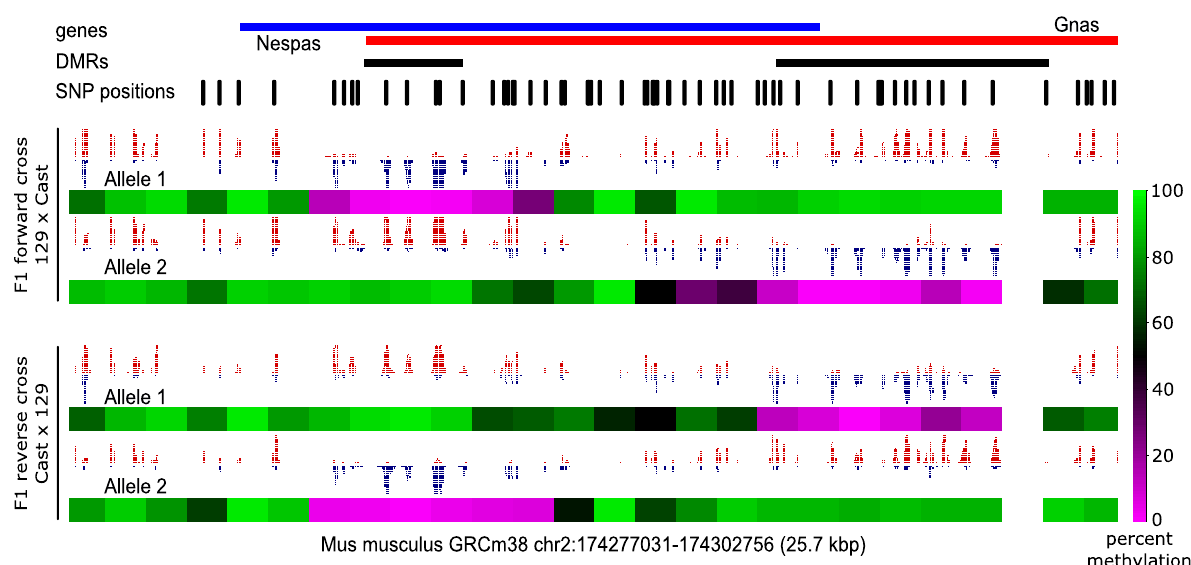
Figure 3. Allele-specific methylation at differentially methylated regions (DMRs) is maintained in a parent-of-origin specific way at the Gnas/Nespas locus. The upstream DMR is methylated exclusively on the paternal allele, while the more downstream DMR is methylated exclusively on the maternal allele in both forward (129 x Cast) and reverse crossed (Cast x 129) hybrid mice. SNP positions were N-masked and used for allele-specific sorting with SNPsplit. Allele 1: 129X1/SvJ reference (129). Allele 2: Cast/EiJ strain (Cast). Red or blue dots in the graph represent calls for methylated or unmethylated cytosines, respectively (CpG context only). The percentage methylation was determined for 2000 bp windows for the region shown using the Bisulfite Methylation Pipeline in Seqmonk 25 (default options). Data taken from 6, GEO accession: